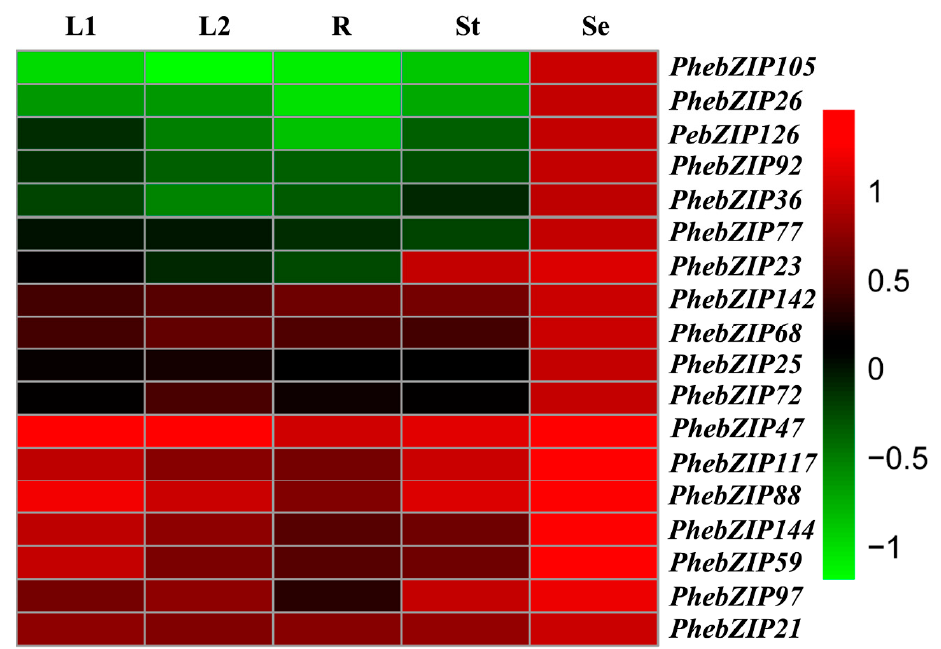
Figure 10. Expression analysis of PhebZIP genes across different tissues and developmental stages. Samples were obtained from young leaves, mature leaves, roots, stems, and seeds. Color scale erected vertically at the right side of the picture represents log10 expression values, green indicates lower and red higher transcript abundance. L1: mature leaves; L2: mature leaves; R: roots; St: stems; Se: seeds.